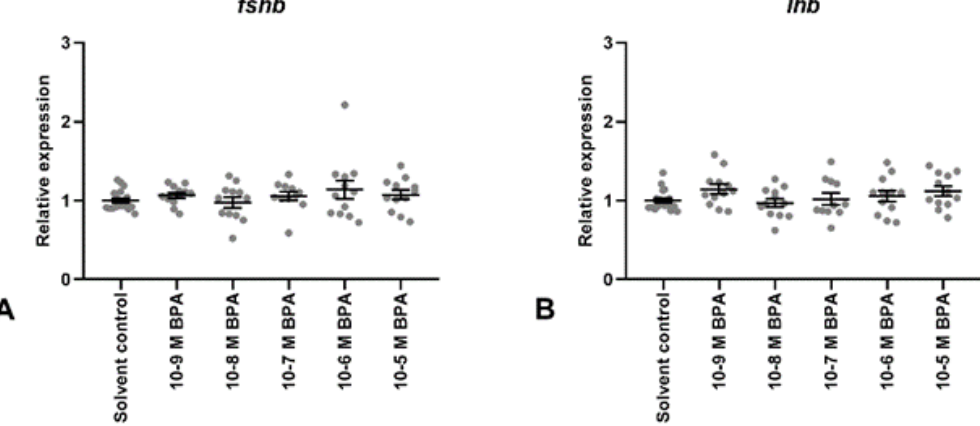
Figure 2. Gene expression of gonadotropin subunits ( FSHb ; ( A ), LHb ; ( B )) in Atlantic cod pituitary cells after 7 days of primary culture w / wo BPA added to the culture media for the last 72 h. Each data point represents the sample fold change relative to mean solvent control. For each column, the group mean ± SEM is indicated ( n = 11–18). No statistical di ff erences between groups were detected (tested by Kruskal–Wallis; ( A ), or one-way ANOVA; ( B )).